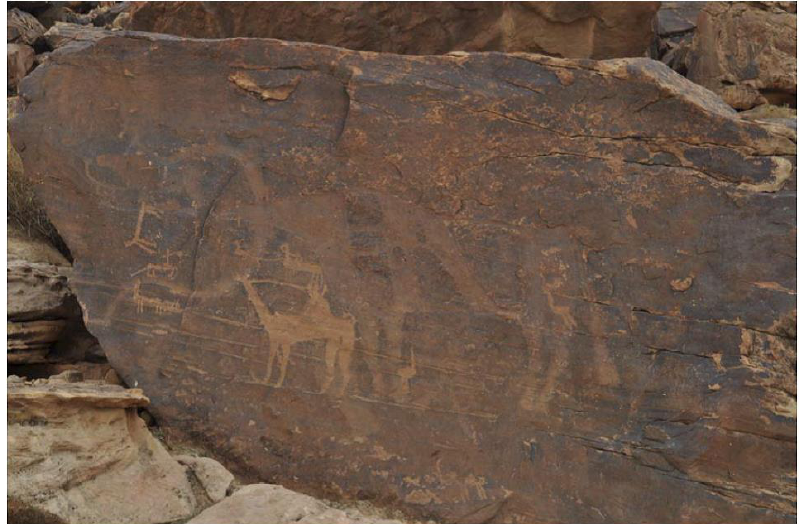
Figure 2. Bovid representing cool and humid climate, while camel superimposed